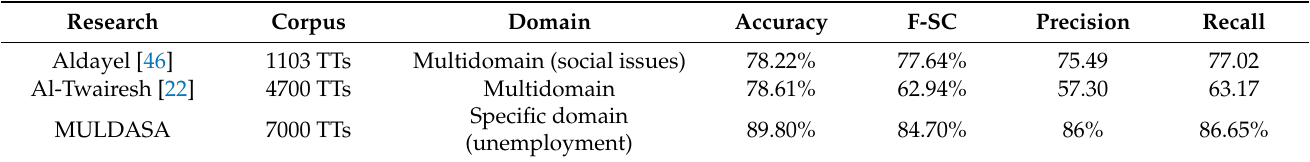
Table 16. Findings from Al-Twairesh and Adayel corpora using our LX-based